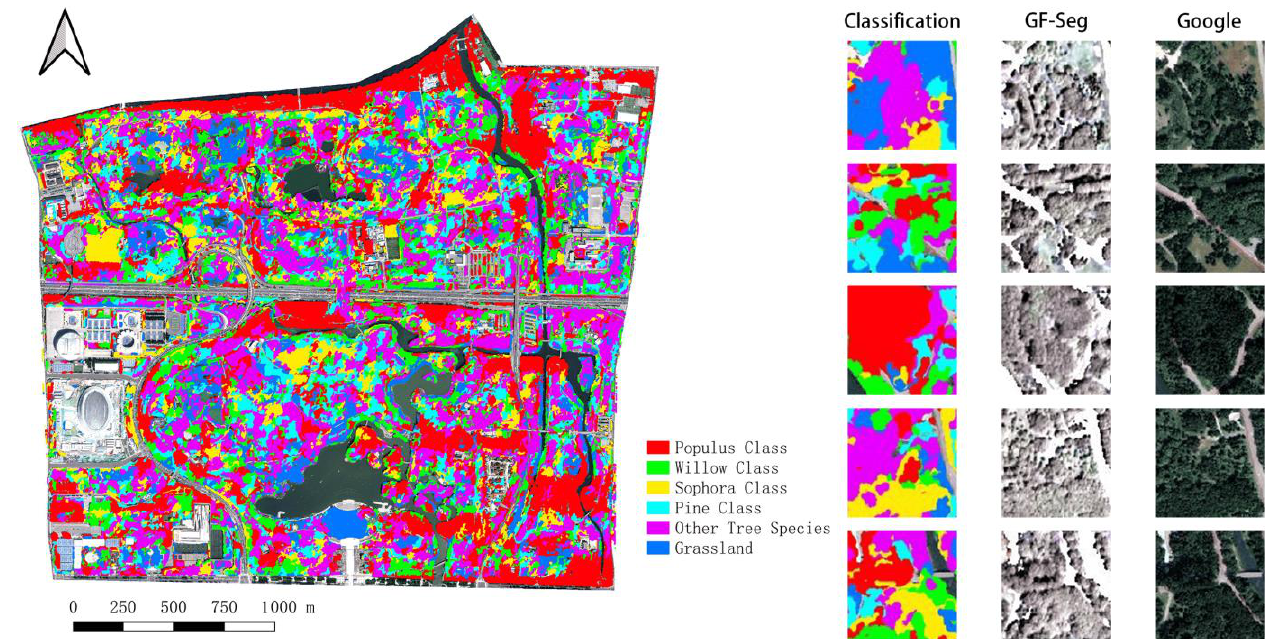
Figure 9. Classification results.